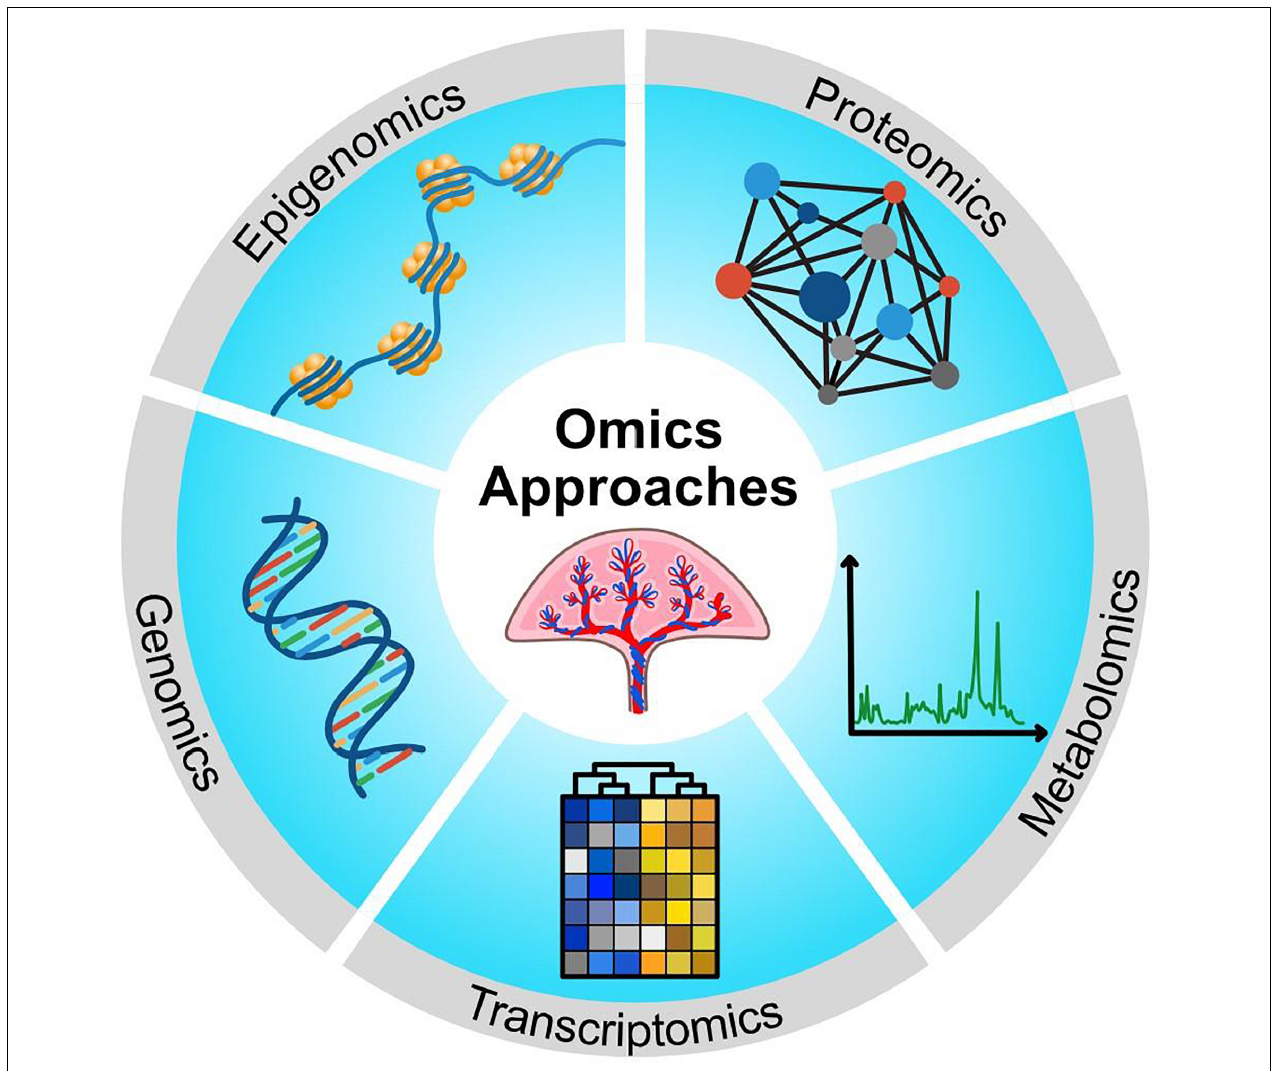
FIGURE 2 | Schematic showing multiple omics approaches that have been used to make new discoveries about STB